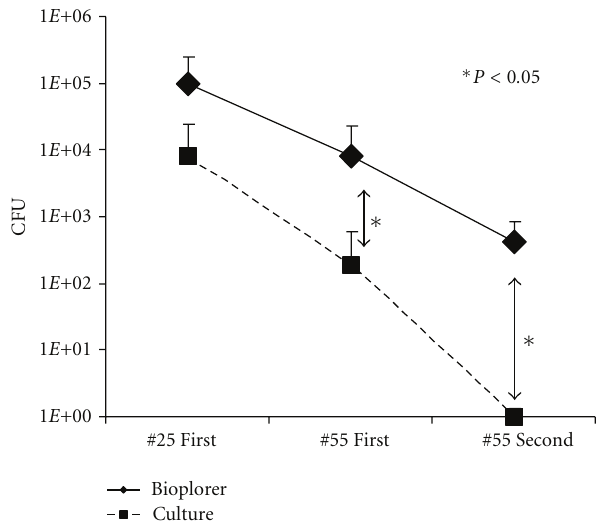
Figure 1: The mean bacterial counts (CFUs) in the samples (cases 1 to 6) at #25 First (at the beginning of the treatment), #55 First (at the end of the first day of treatment), and #55 Second (at the next appointment day) by Bioplorer and